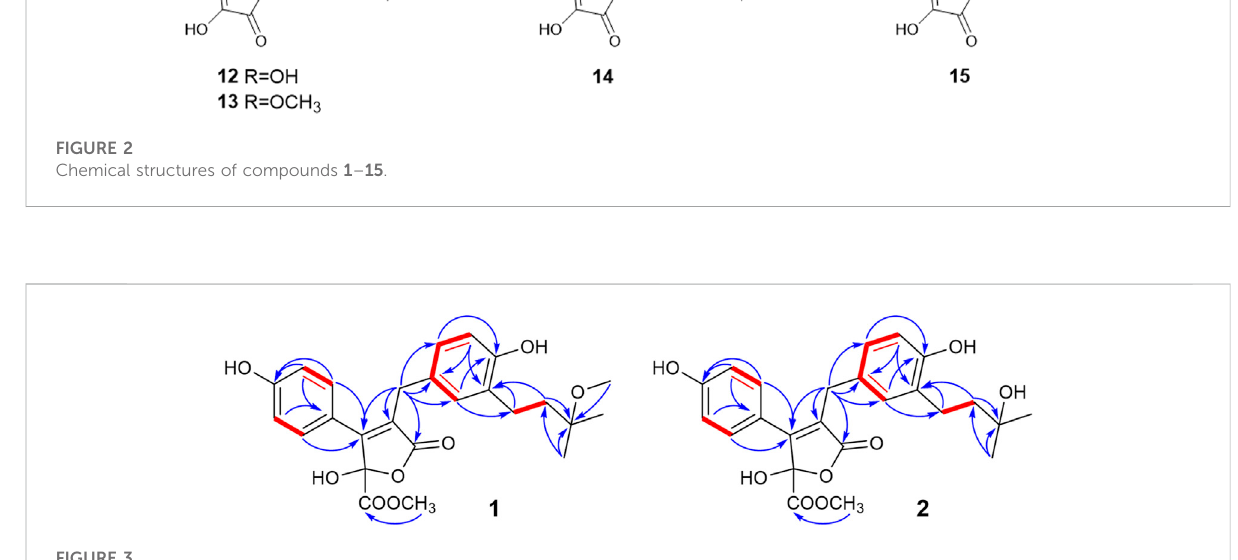
FIGURE 3 Key COSY and HMBC correlations of compounds 1 – 2